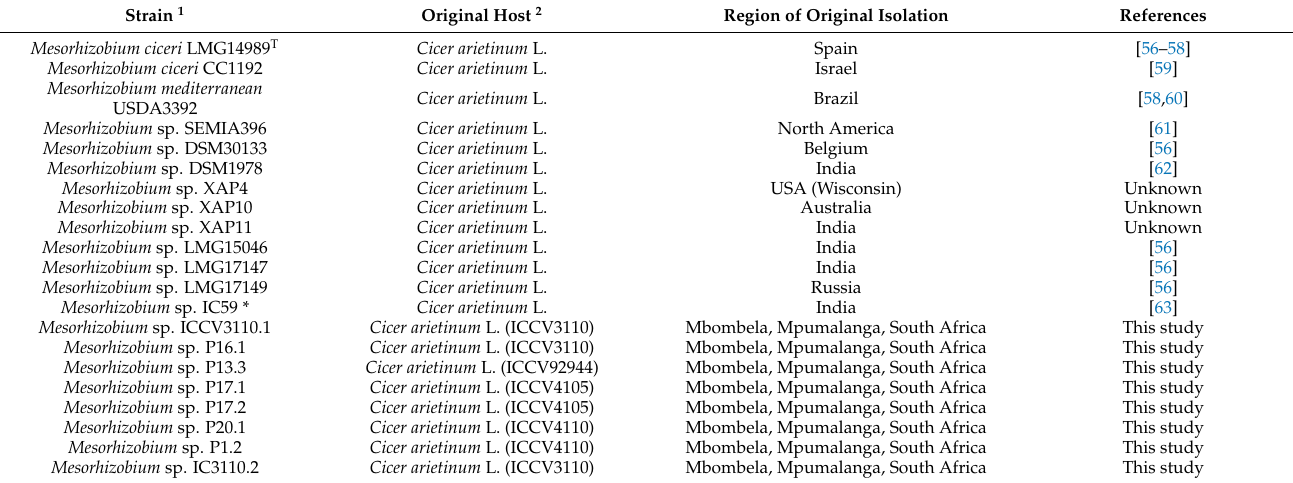
Table 1. Chickpea-associated Mesorhizobium strains incorporated in this study, their source, and country of initial isolation. The respective genotypes of chickpea from which field nodules were collected for isolation of rhizobia in Mpumalanga South Africa are indicated in